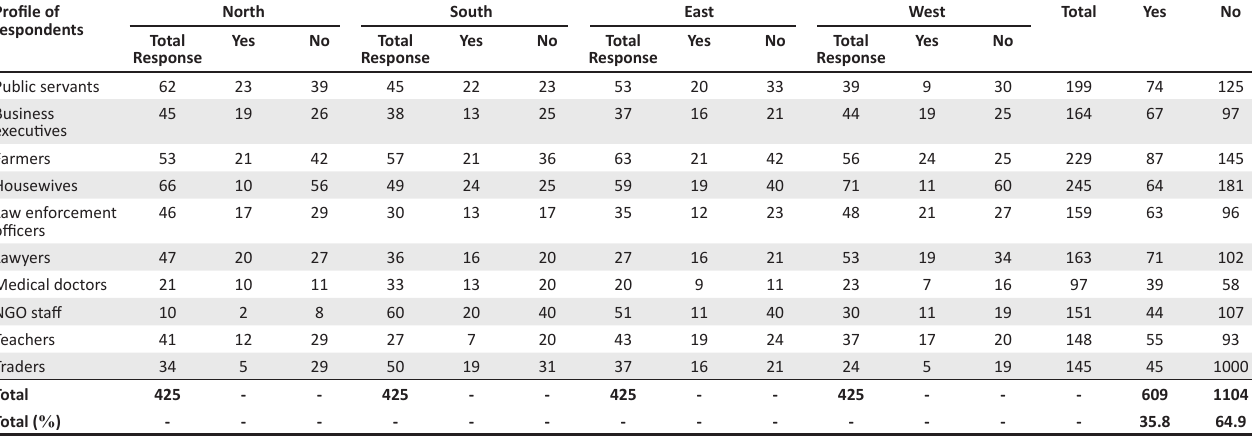
TABLE 2: Nature of political leadership and economic development. Profile of